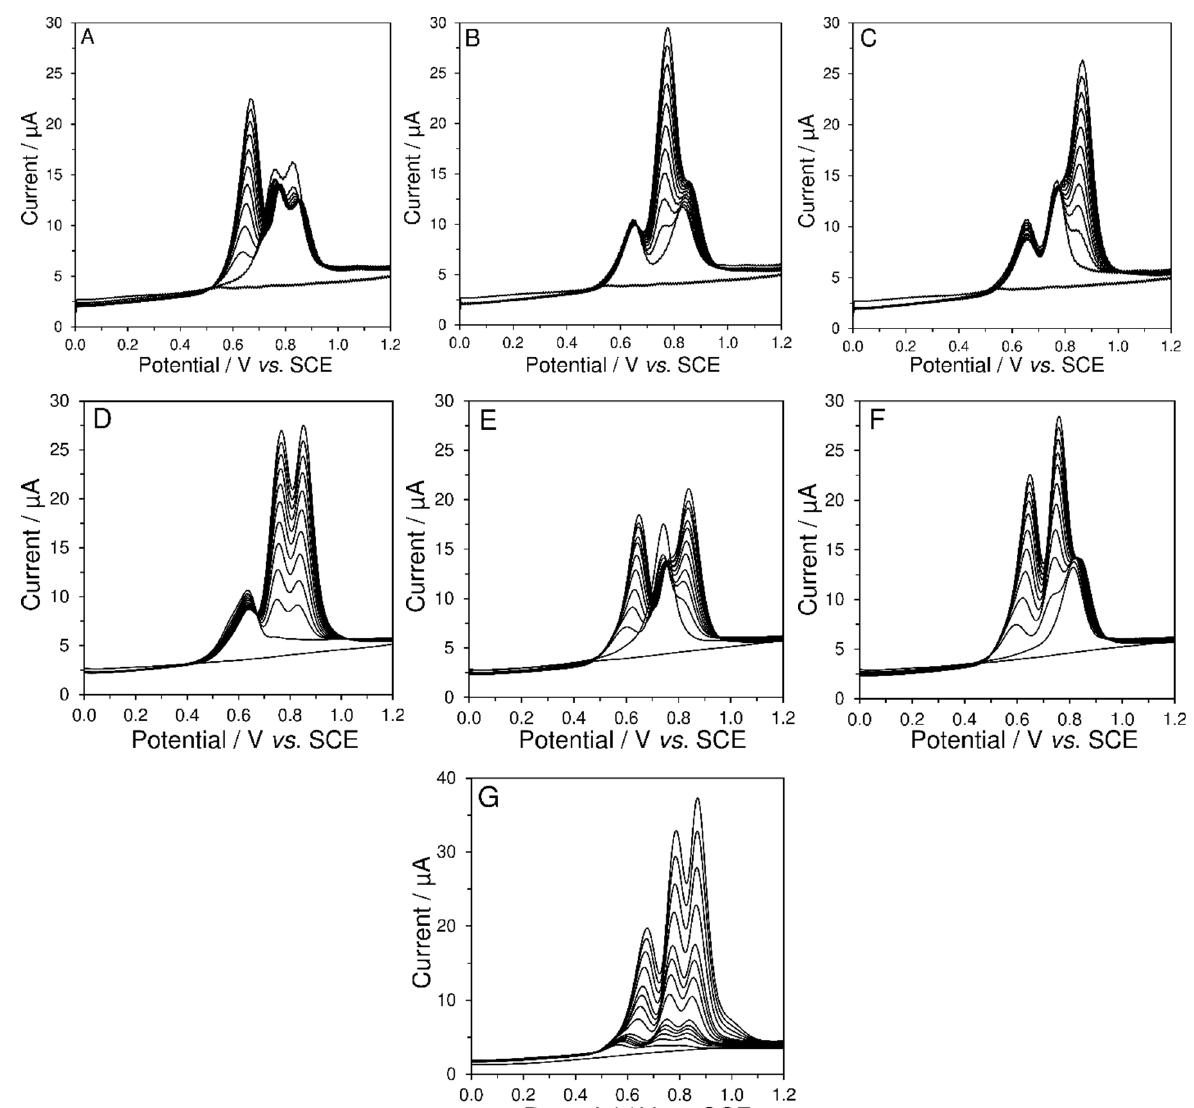
Figure 4. SWVs of 20–200 μ mol L − 1 of one tocopherol form when two others had a constant concentration of 50 μ mol L − 1 (varying α concentrations); ( A ), varying γ concentrations; ( B ) and varying δ ; ( C ). SWVs of 20–200 μ mol L − 1 of two tocoph- erols when one had a constant concentration of 50 μ mol L − 1 (varying γ and δ concentrations); ( D ) varying α and δ concen- trations; ( E ) and varying α and γ concentrations;( F ). Simultaneous voltametric detection of 3–300 μ mol L − 1 of all tocopherol forms ( G ). All voltammograms were obtained at GCE in pure MeCN containing 0.1 mol L − 1 LiClO 4 , E step = 1 mV, E ampl = 25 mV, and f = 25 Hz. The potential was scanned from 0.0 to 1.2 V.